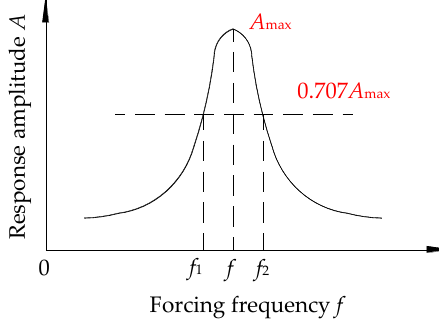
Figure 17. Half-power bandwidth method. Table 8. Natural frequencies and damping